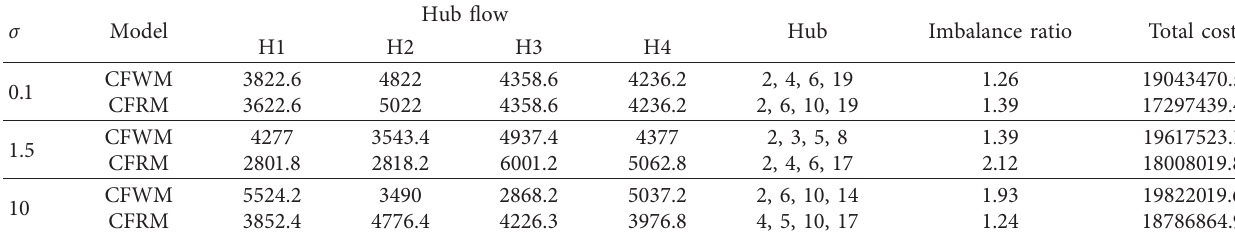
Table 7: Impact of congestion function parameter σ on model results.